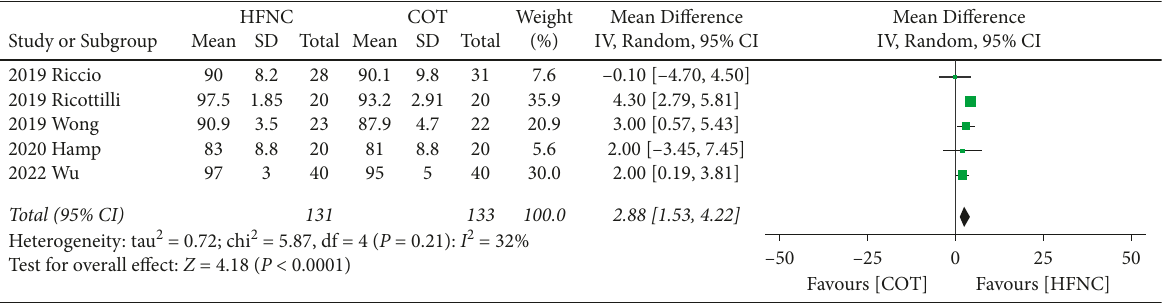
Figure 5: Forest plot comparing the lowest SpO